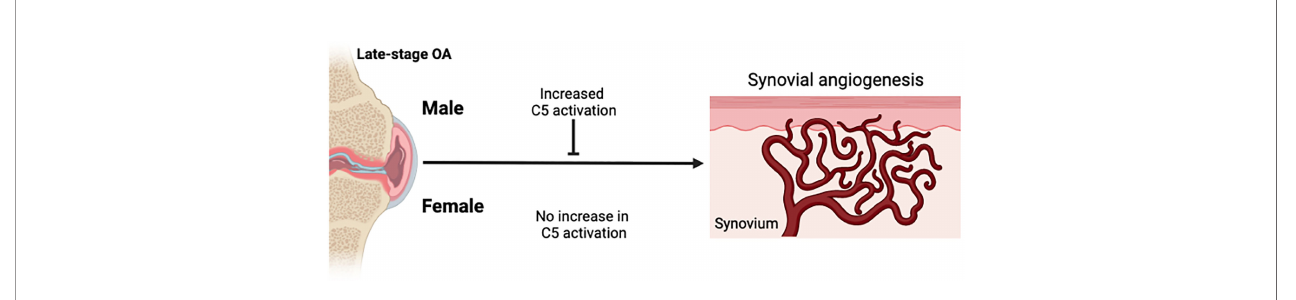
FIGURE 4 | Schematic summary of sex-differences in complement activation and synovial angiogenesis. Knee OA is associated with synovial tissue angiogenesis. In males with knee OA, complement activation was increased and associated with reduced synovial vascularization. In females with knee OA, complement activation was not increased and no association between complement activation and synovial vascularization was detected. Figure created in